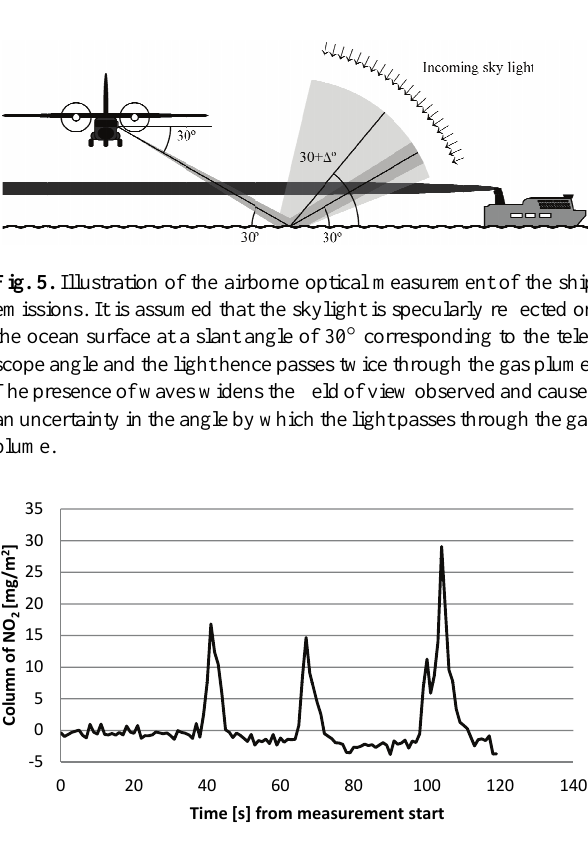
Fig. 6. Optical measurement of NO 2 for the flight transect il- lustrated in Fig. 3. The standard deviation of the background is 0.44mgm − 2